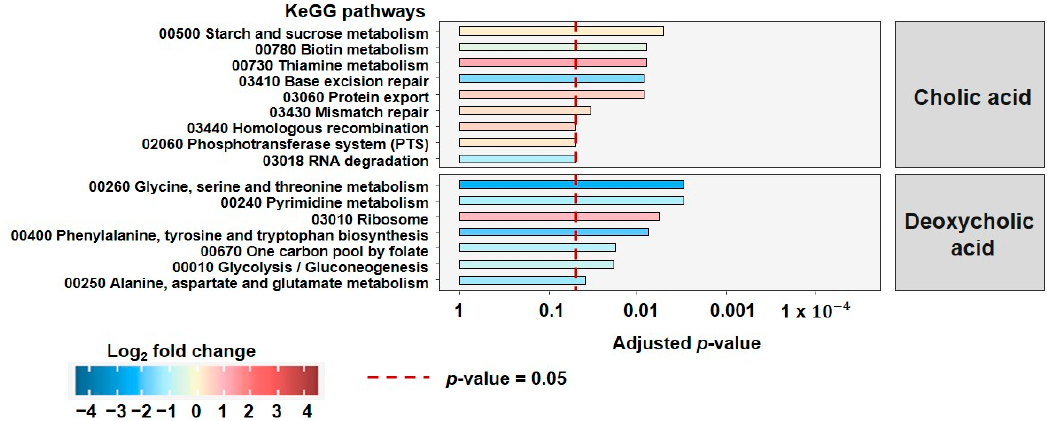
Figure 4. Molecular response of C. ramosum towards CA and DCA in co-culture with E. lenta vs. single culture. Depicted are the significantly altered KEGG metabolic pathways based on the relative abundance of proteins detected. The proteins stem from the bacterial pellet harvested from the end of the bile acid stress assays. The direction of the change is color-coded, red indicates an increase, blue a decrease in the fold change in the co-culture.